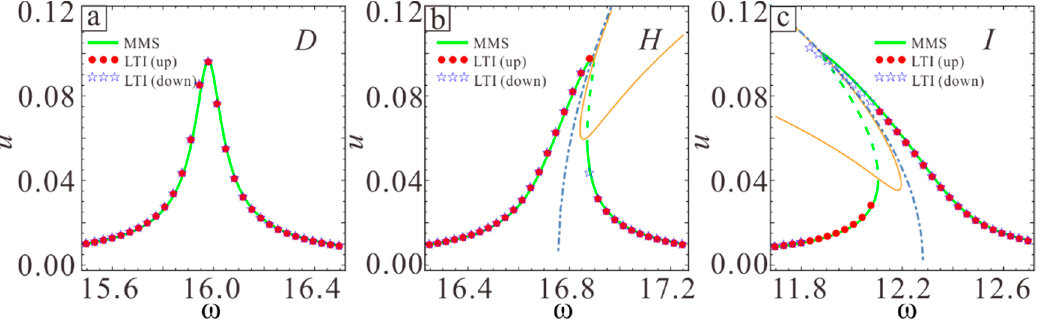
Figure 10. Frequency response curves for D ( a ), H ( b ), and I ( c ). The solid line shows the theoretically stable solution and the dotted line shows the theoretically unstable solution.